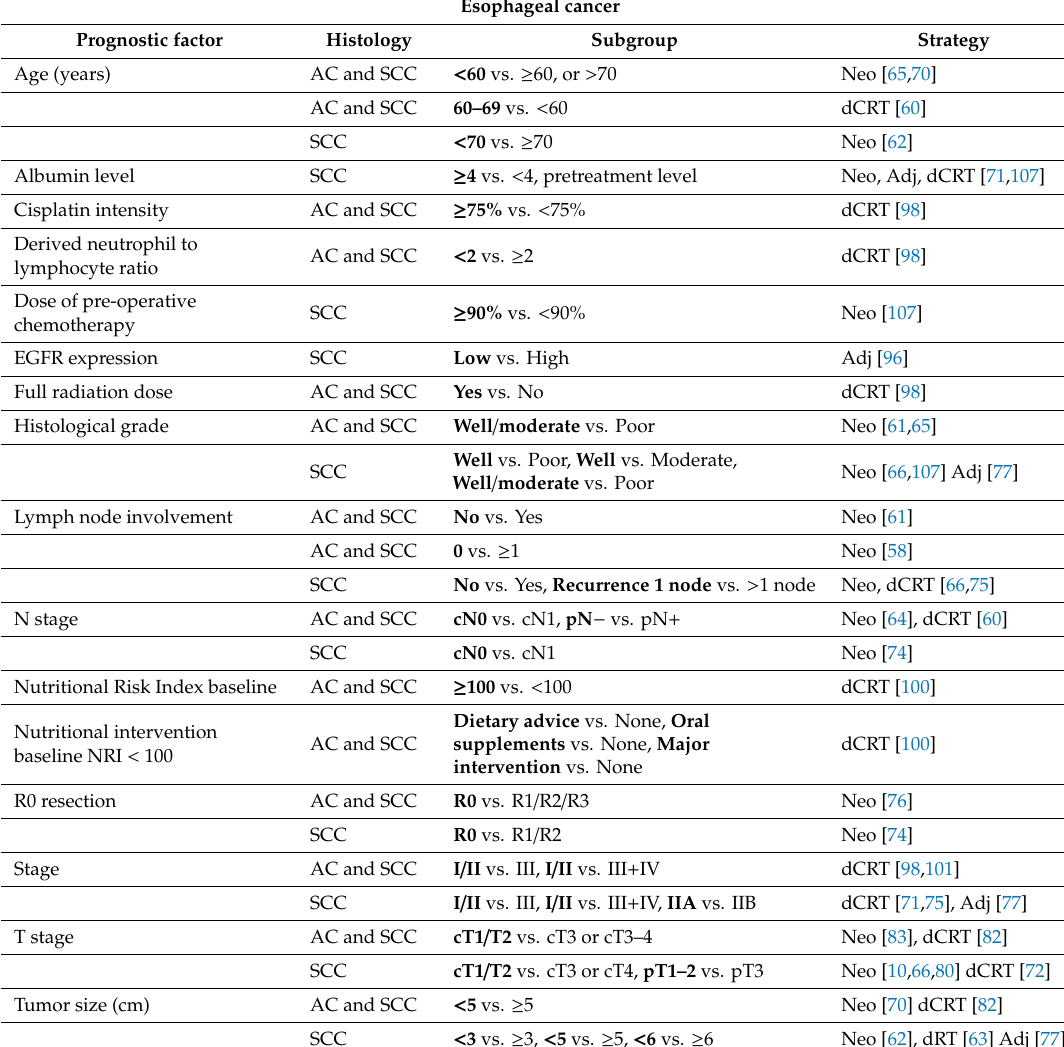
Table 2. Potentially clinically relevant prognostic factors identified from multivariate OS analyses for the curative treatment of esophageal cancer. Highlighted are the subgroups which showed significant ( p < 0.05) survival benefit over the other subgroup for potentially clinically relevant prognostic factors, if it was possible to identify this from individual studies. Per factor a subdivision was made between studies which included both adenocarcinoma and squamous cell carcinoma (SCC) and studies which only included squamous cell carcinoma (SCC) patients. Under the heading strategy, the treatment setting of RCTs are listed for each prognostic